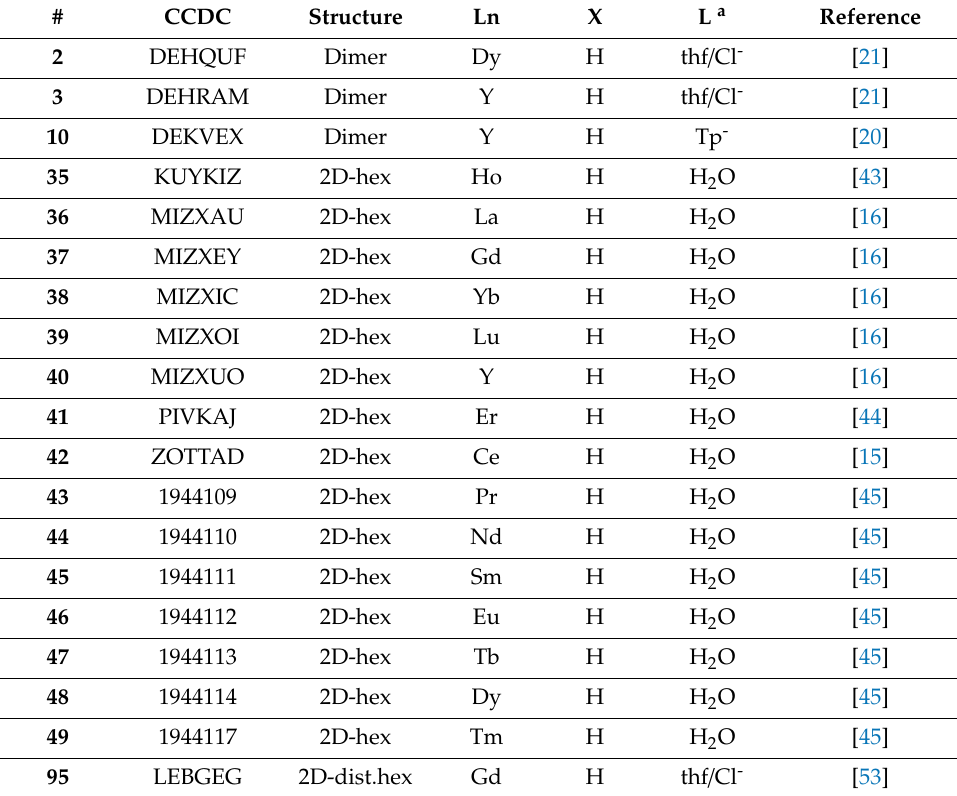
Table 8. Structurally characterized Ln compounds with dhbq 2 − .